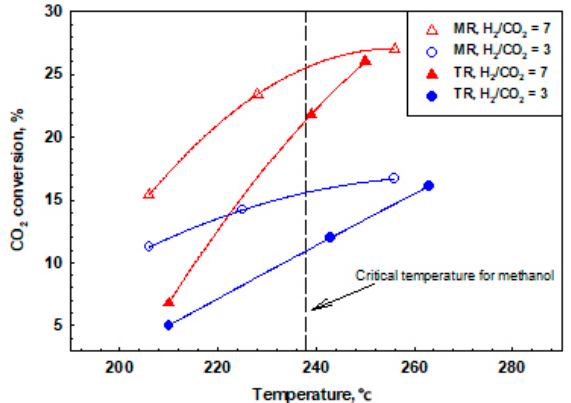
Figure 16. CO 2 conversion versus temperature for both membrane and traditional reactors, p = 20 bar, H 2 / CO 2 = 3 and 7, total feed rate = 800 mL / min, catalyst weight = 8 g. Reproduced from [77] with the permission of Elsevier.